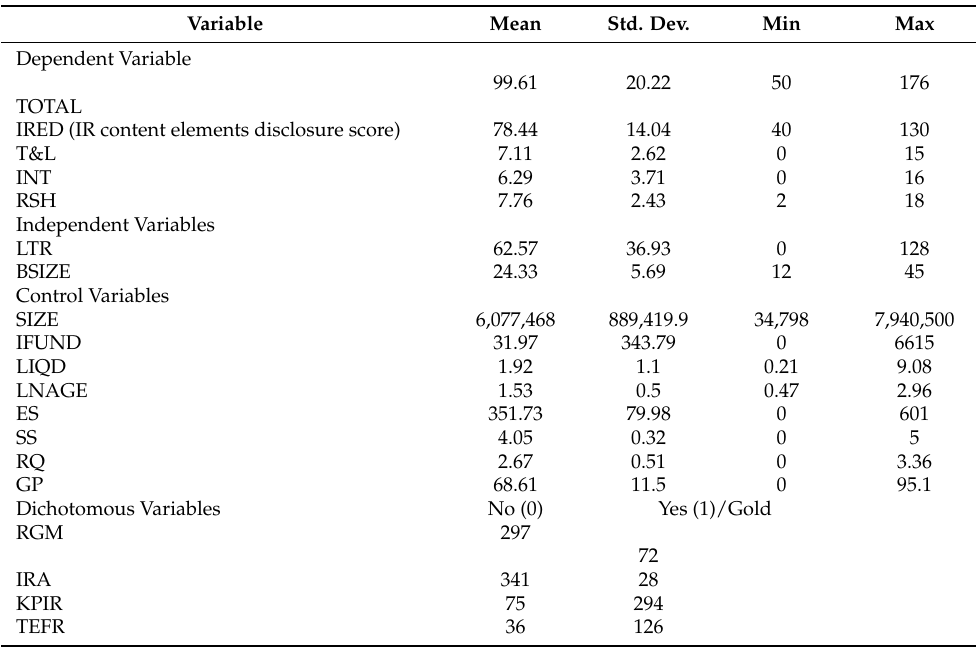
Table 2. Descriptive statistics of study